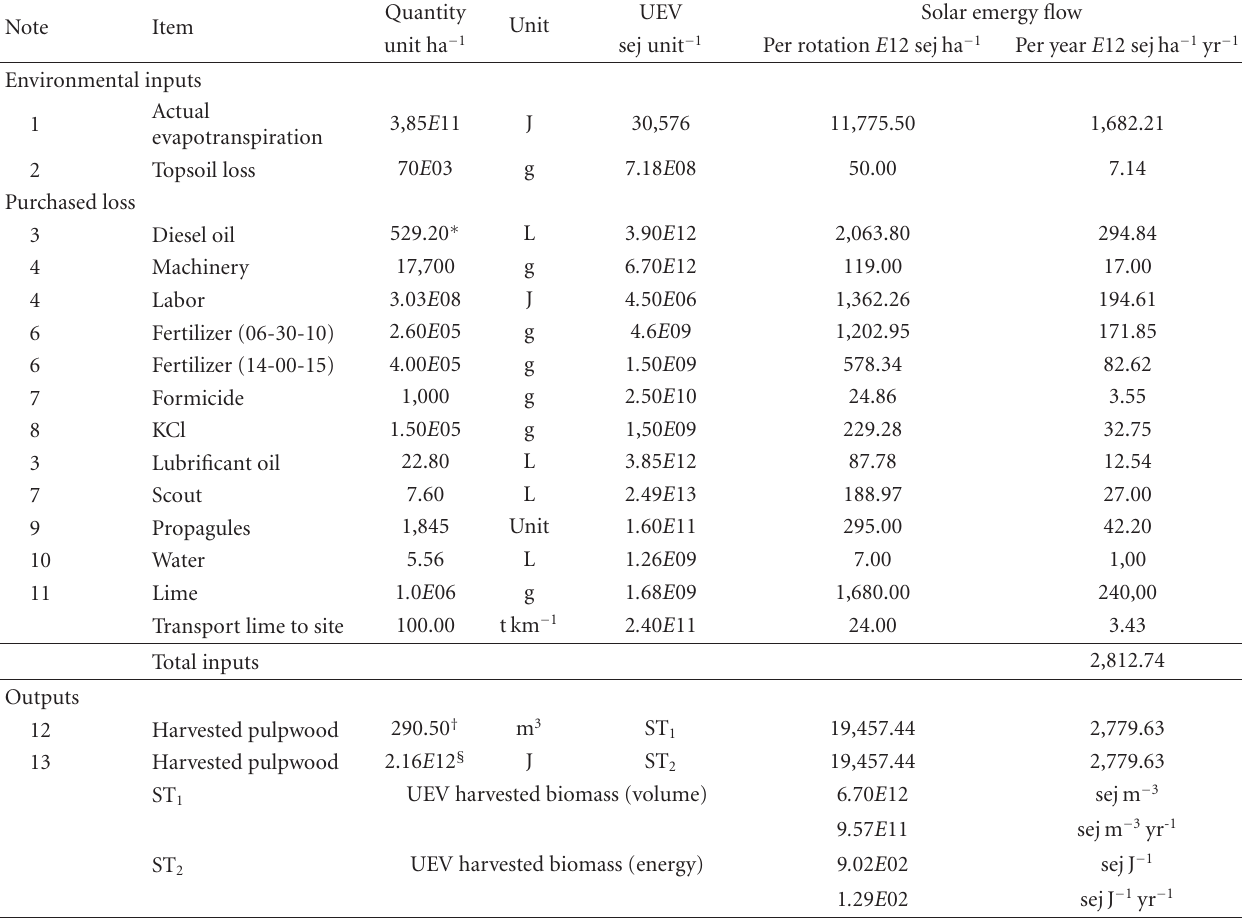
Table 2: Emergy evaluation of eucalyptus plantation (7-year cycle); yields are for pulpwood only.